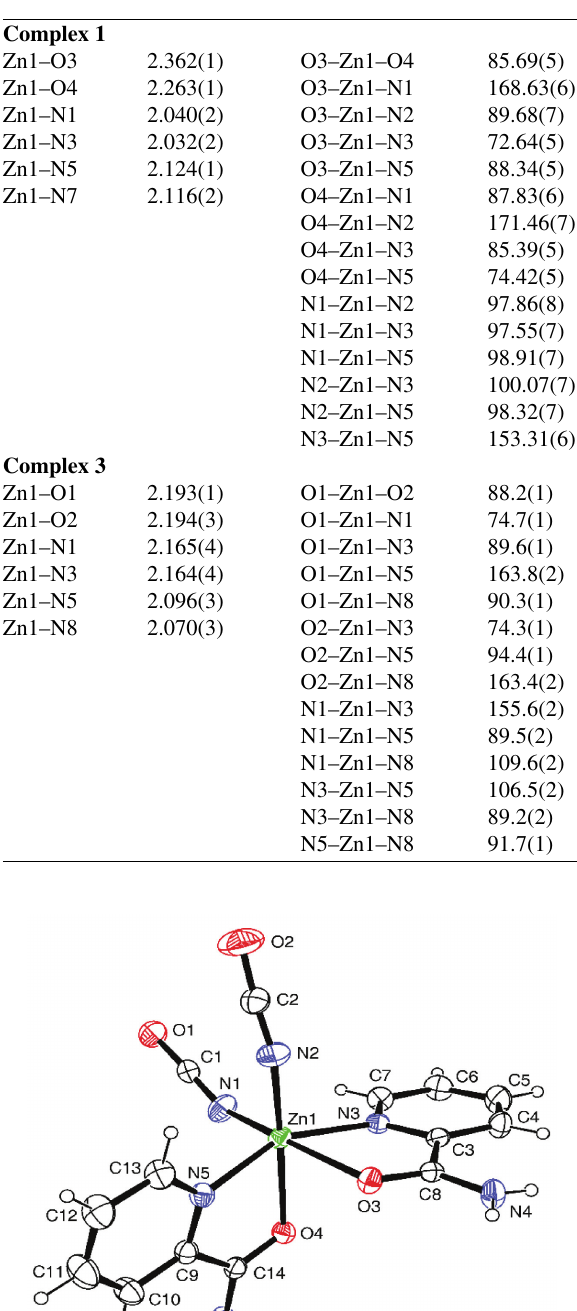
Table 2. Selected bond distances (Å) and angles ( o ) for complexes 1 and 3 .